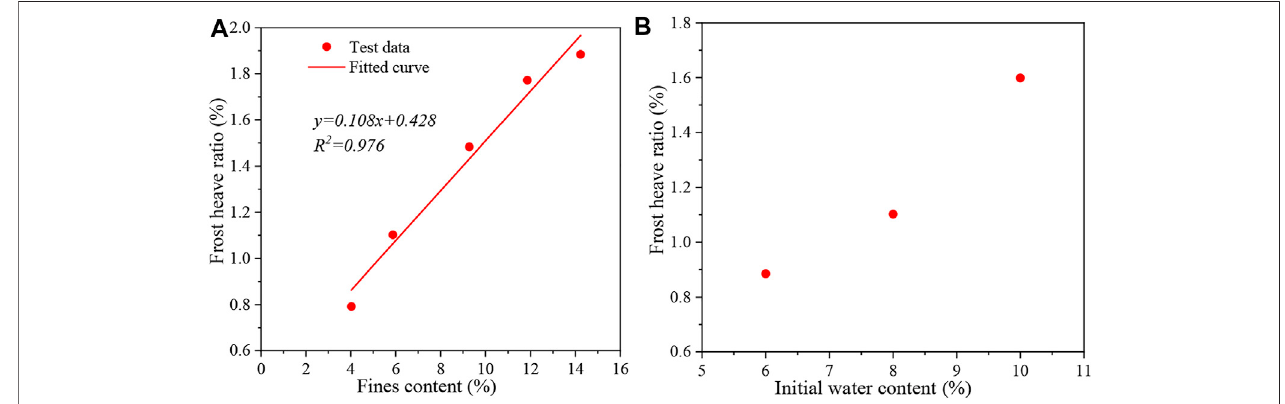
FIGURE 12 | The in fl uence of fi nes content and initial water content. (A) Relationship of frost heave ratio and fi nes content; (B) relationship of frost heave ratio and initial water content.